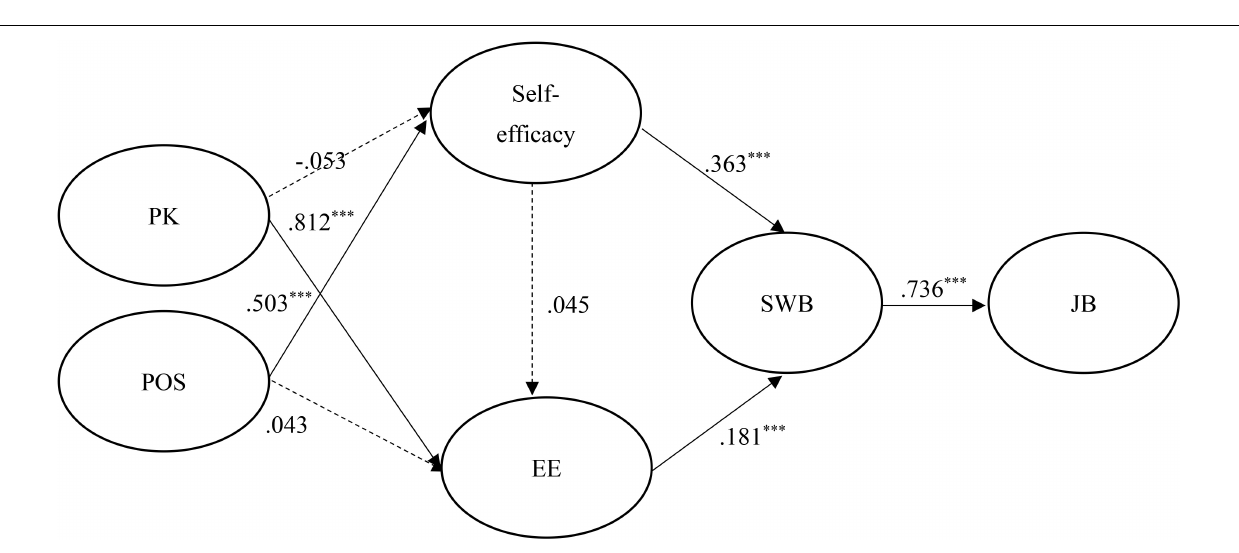
FIGURE 3 | Structural model of mainland China